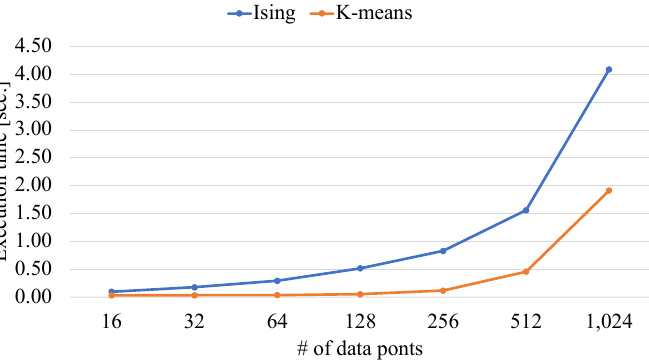
Figure 14. Execution times of the proposed Ising-based kernel clustering and kernel K-means.